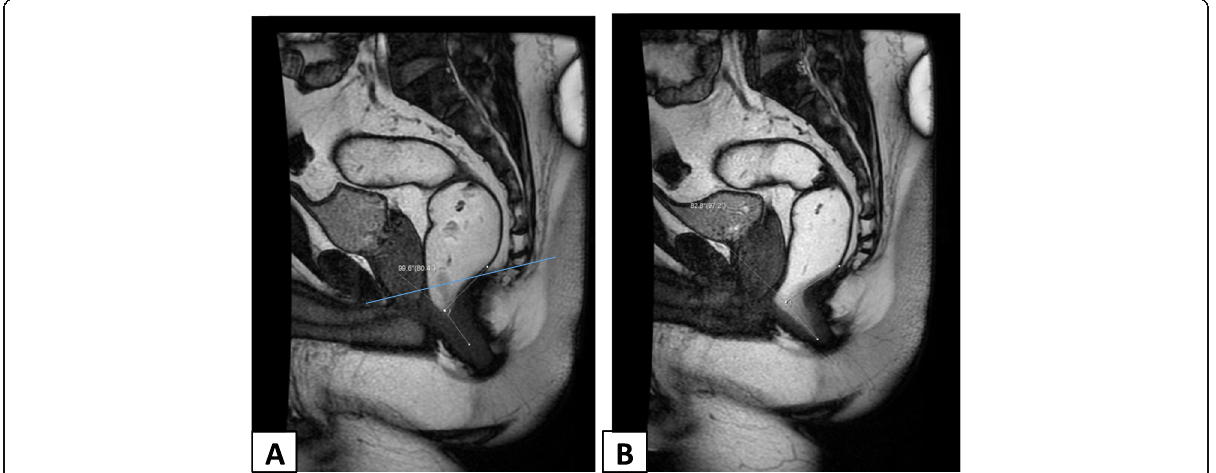
Fig. 6 Mid-sagittal SSFP obtained ( a ) at rest showing ano-rectal angle measuring 99°, b during defecation showing decrease in ano-rectal angle measuring 82° suggestive of paradoxical